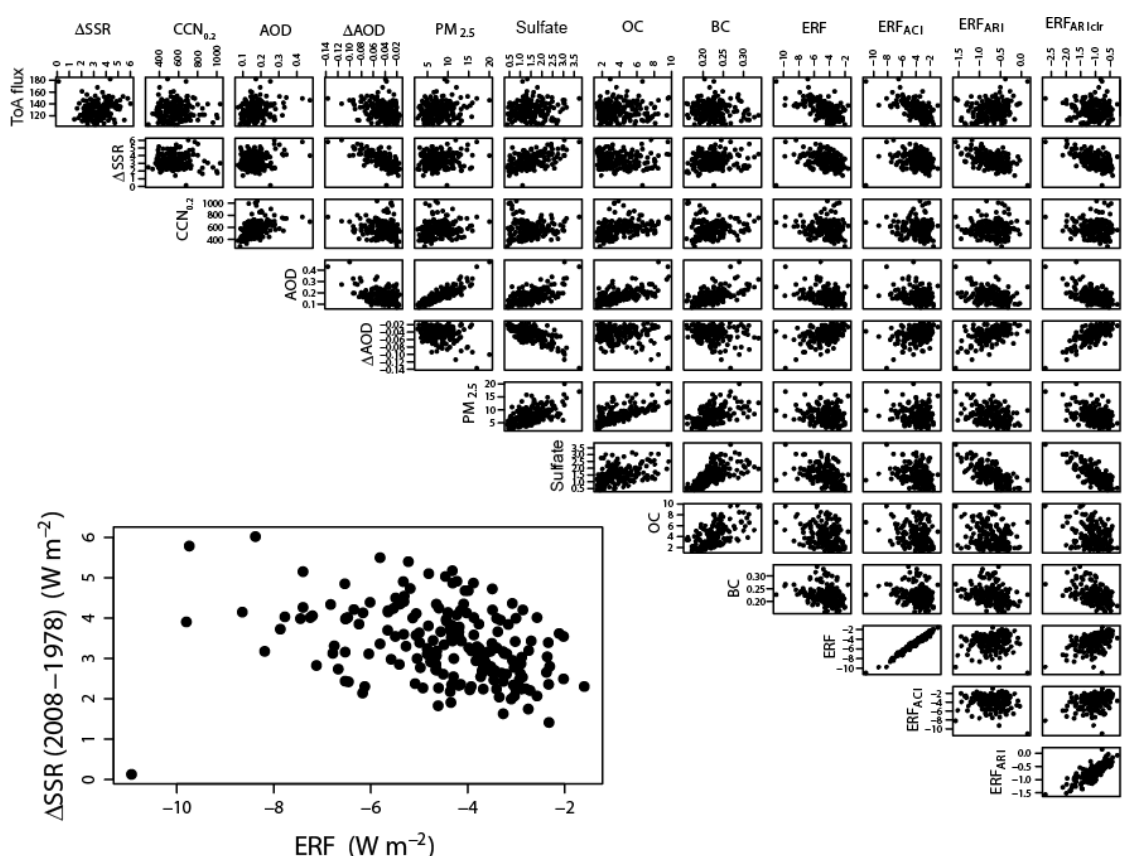
Figure 2. Pairwise scatter plots of the PPE member regional mean model output for Europe in July, for the aerosol properties used as constraints: ToA flux (Wm − 2 ); change in SSR ( (cid:49) SSR, Wm − 2 ) between 1978 and 2008; CCN 0 . 2 concentration (cm − 3 ); AOD; surface mass concentrations of PM 2 . 5 , sulfate, OC and BC (µgm − 3 ); the change in AOD ( (cid:49) AOD, Wm − 2 ) between 1978 and 2008; and the 1850– 2008 forcing variables: aerosol ERF, ERF ACI , ERF ARI and ERF ARIclr (Wm − 2